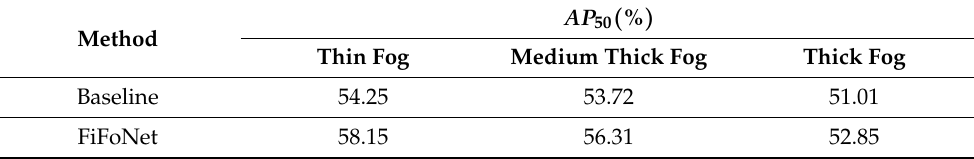
Table 6. Detection results of our FiFoNet with synthetic images on our VisDrone_Foggy dataset.